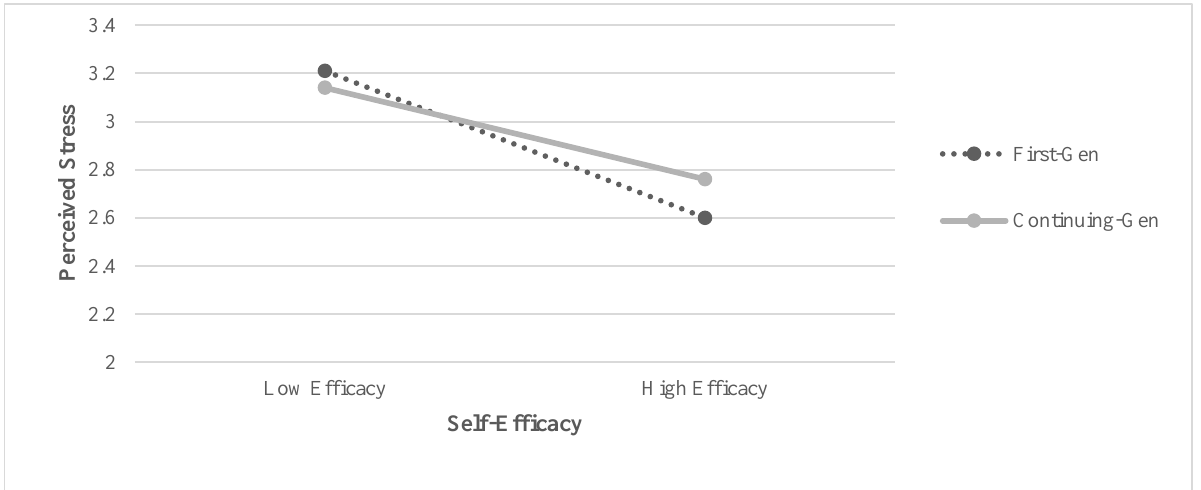
Figure 3. First-generation status moderated self-efficacy and perceived stress.